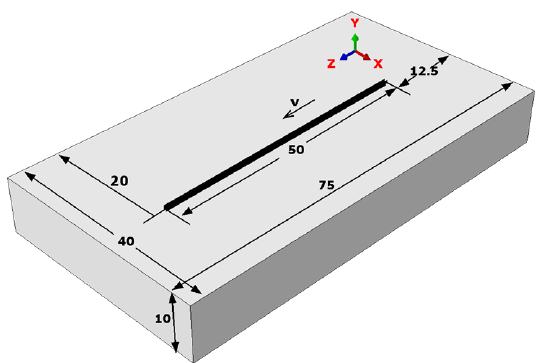
Figure 3. Schematic of the autogeneous laser weld test showing the overall dimensions, the direction of the welding speed, and the x, y, and z directions. Units in mm.